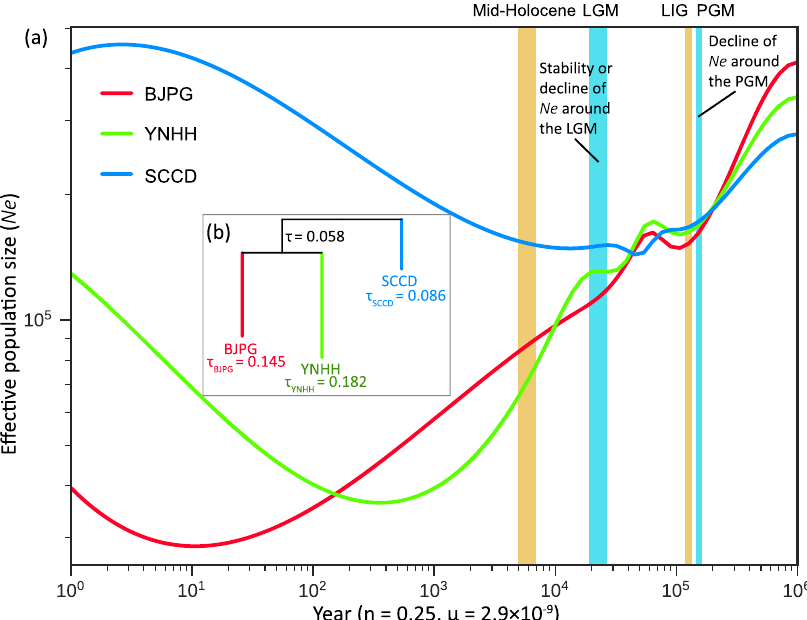
Fig. 4 Variation in effective population size and divergence times of three populations of the oriental fruit moth. a Variation in effective population size ( Ne ) inferred by the SMC ++ analysis. Warm climatic periods are labeled by yellow bars, while cold climatic periods are labeled by blue bars. A mutation rate ( μ ) of 2.9 × 10 − 9 per site per generation and a generation time ( n ) of 0.25 years was used. b Divergence times estimated using KimTree. The parameter τ k ≡ t k /(2N K ) is the length of the branch leading to population k. Mid-Holocene, 6000 years before present; LGM the last glacial maximum, ∼ 26.5 – 19 thousand years ago (kya); LIG the last interglacial period, 140 – 120 kya; PGM the penultimate glacial maximum, ∼ 155 – 140